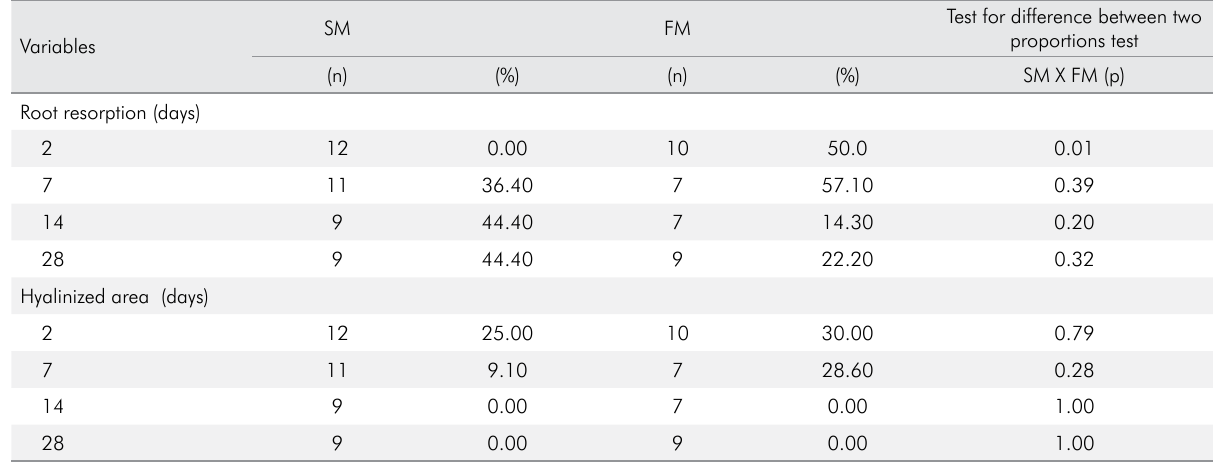
Table 3. Percentage of root resorption and hyalinized areas in saline with tooth movement (SM) and fluoxetine with tooth movement (FM)